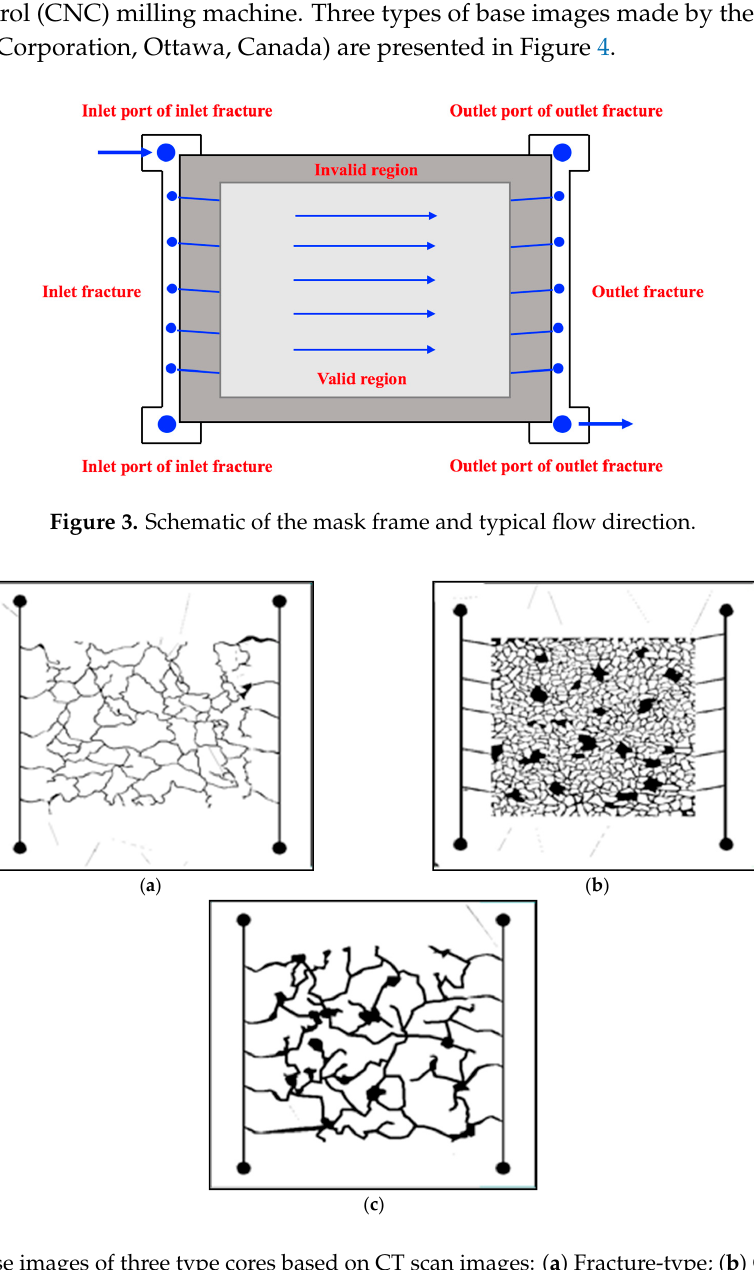
Figure 4. Base images of three type cores based on CT scan images: ( a ) Fracture-type; ( b ) Cavity-type; ( c )